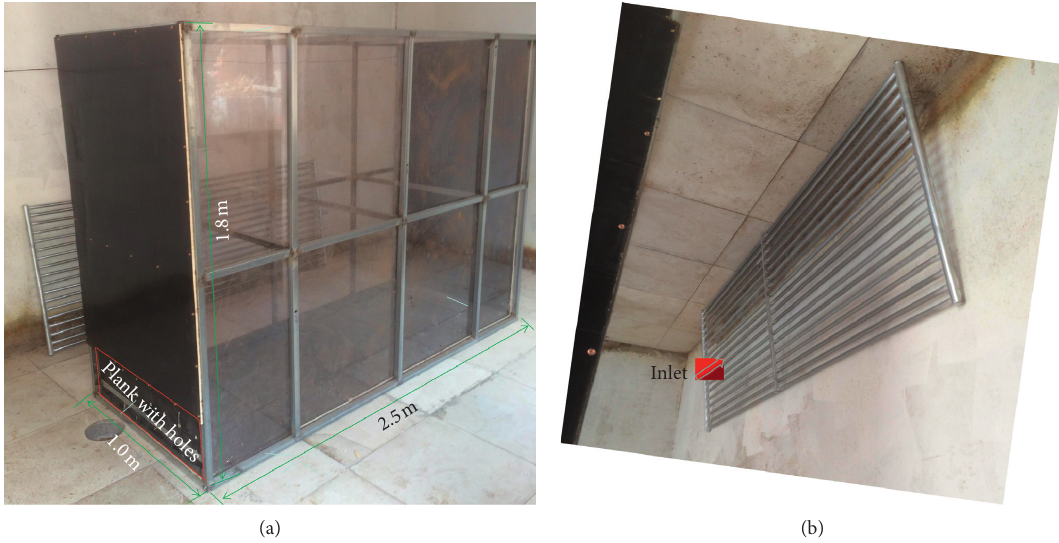
Figure 3: (a) Model test box and (b) rainfall simulator.